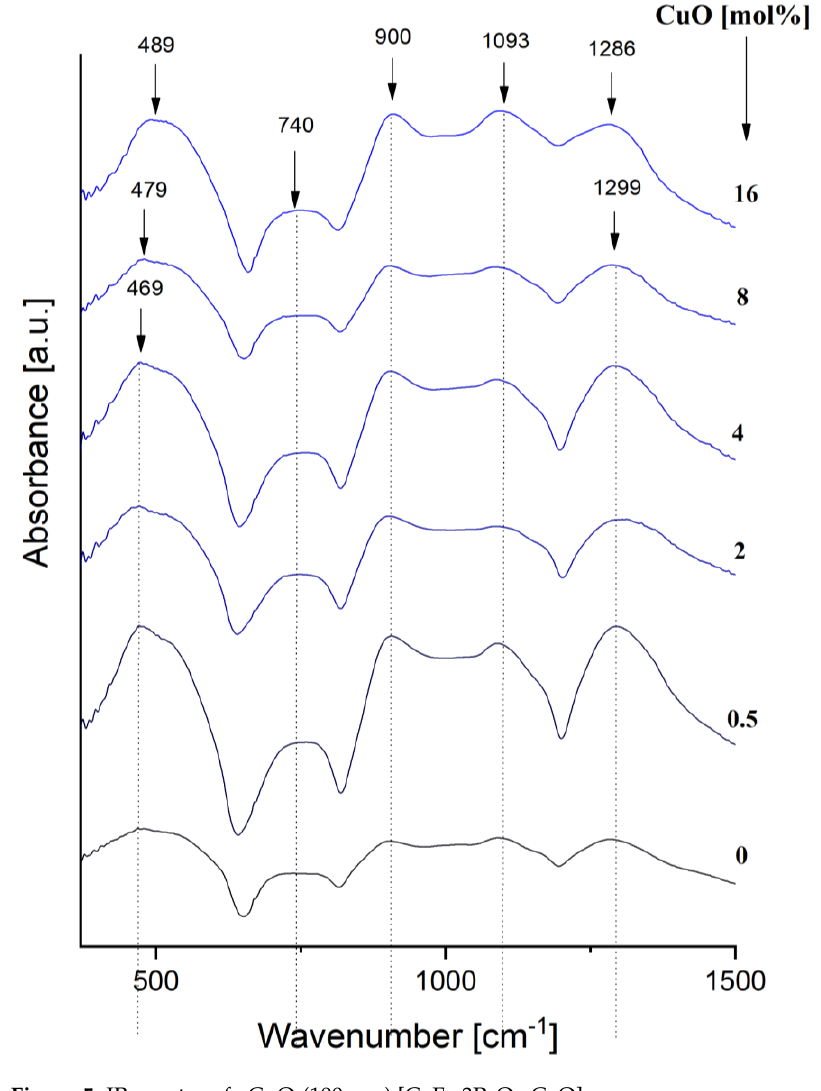
Figure 5. IR spectra of xCuO∙(100 - x) [CaF 2 ∙3P 2 O 5 ∙CaO].